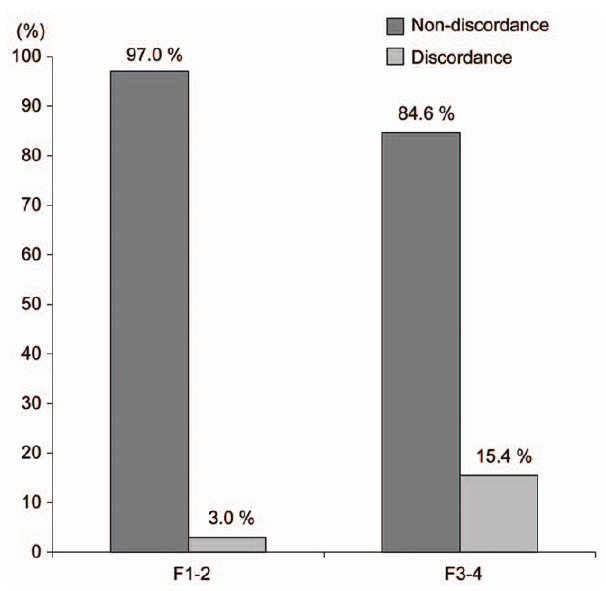
Figure 3. Percentage of patients with non-discordance and those with discordance in fibrosis stage 1–2 (F1–2) vs. fibrosis stage 3–4 (F3–4). Patients with F3–4 had the significantly higher proportion of discordance than those with F1–2 (15.4% vs. 3.0%, P , 0.001).